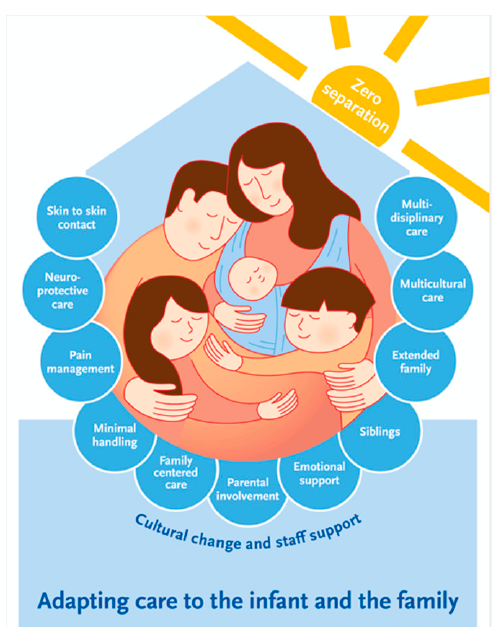
Figure 3. Elements of providing care adapting to the infants needs in a Single-Family Room NICU.